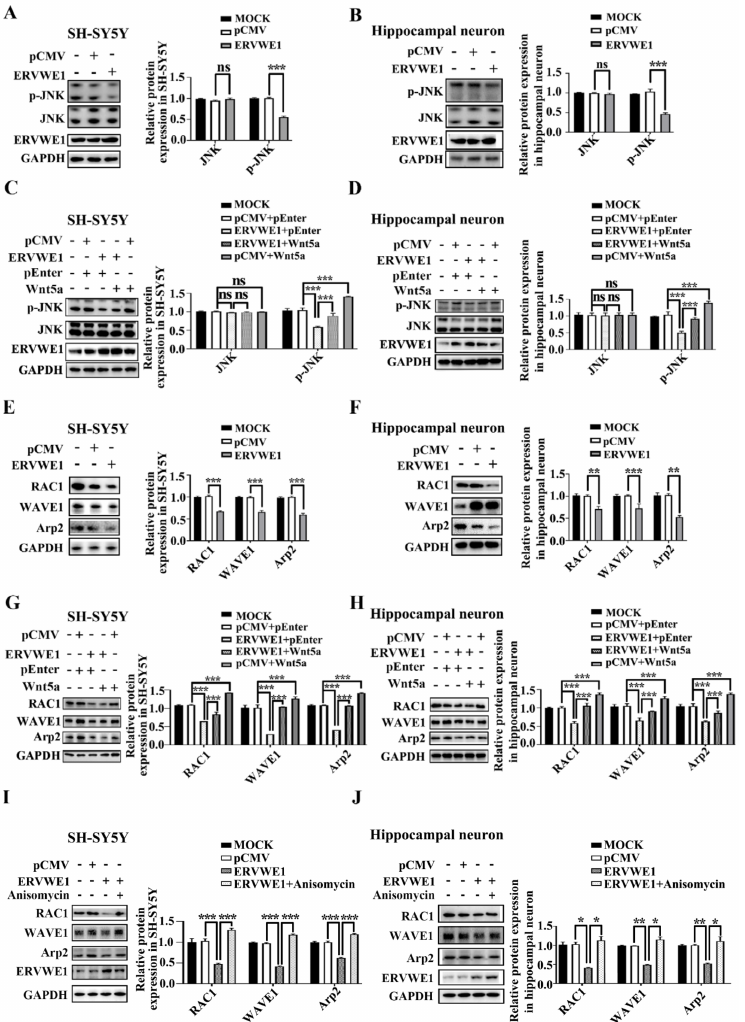
Figure 4. ERVWE1 lessen the expression of Arp2 via JNK-mediated non-canonical signaling pathway. ( A , B ) ERVWE1 down-regulated the protein levels of p-JNK but had no effects on the level of total- JNK in SH-SY5Y cells and rat hippocampal neurons. ( C , D ) Elevated level of Wnt5a could increase the ERVWE1-induced protein expression of p-JNK in SH-SY5Y cells and rat hippocampal neurons. ( E , F ) ERVWE1 down-regulated the protein level of RAC1, WAVE1, and Arp2 in SH-SY5Y cells and rat hippocampal neurons. ( G , H ) Elevated of Wnt5a could increase the ERVWE1-induced protein level of RAC1, WAVE1, and Arp2 in SH-SY5Y cells and rat hippocampal neurons. ( I , J ) Anisomycin elevated the ERVWE1-induced protein level of RAC1, WAVE1, and Arp2 in SH-SY5Y cells and rat hippocampal neurons. *** p < 0.001, ** p < 0.01, * p < 0.05, ns: p >